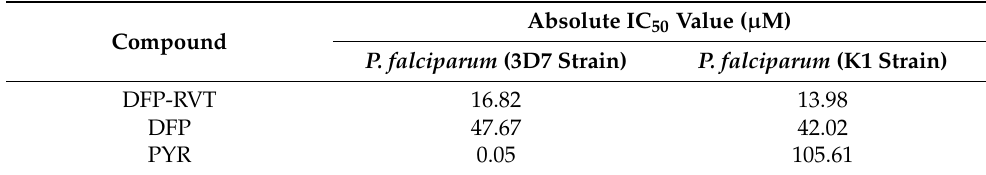
Table 2. Absolute IC 50 values of DFP-RVT, DFP and PYR for inhibition of P. falciparum growth.